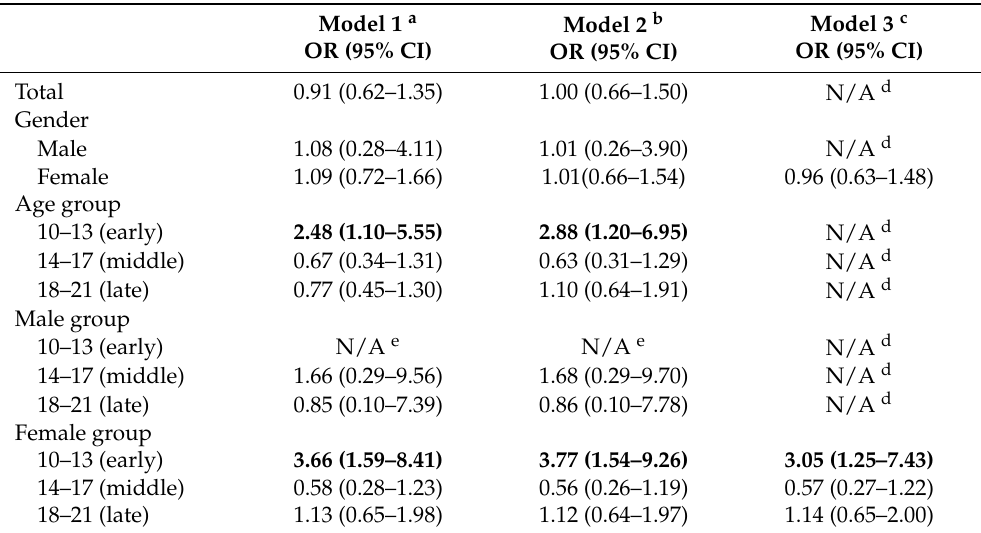
Table 2. Odds ratios and 95% confidence intervals for the relationship between obesity and anemia using a logistic regression